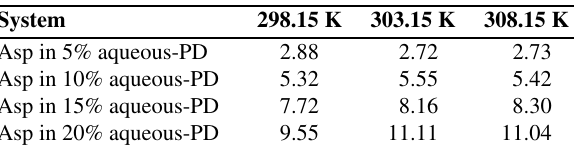
Table 6. Partial molar compressibilities of transfer, K 0 φ , 10 15 /(m 3 mol –1 Pa –1 ), of Asp in aqueous solution of PD at different temperatures.